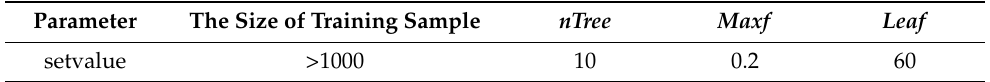
Table 5. Parameter settings.